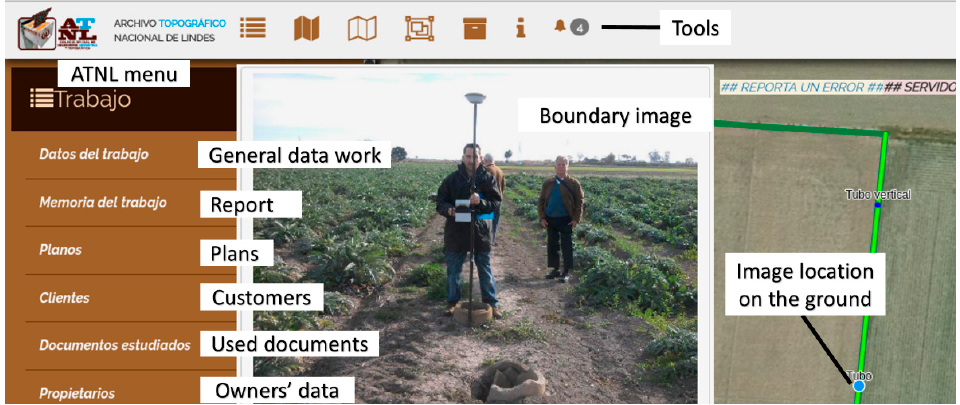
Figure 11. Land registry unit work delimitation watched across the ATNL geoportal. Source: ATNL screen shot. screen